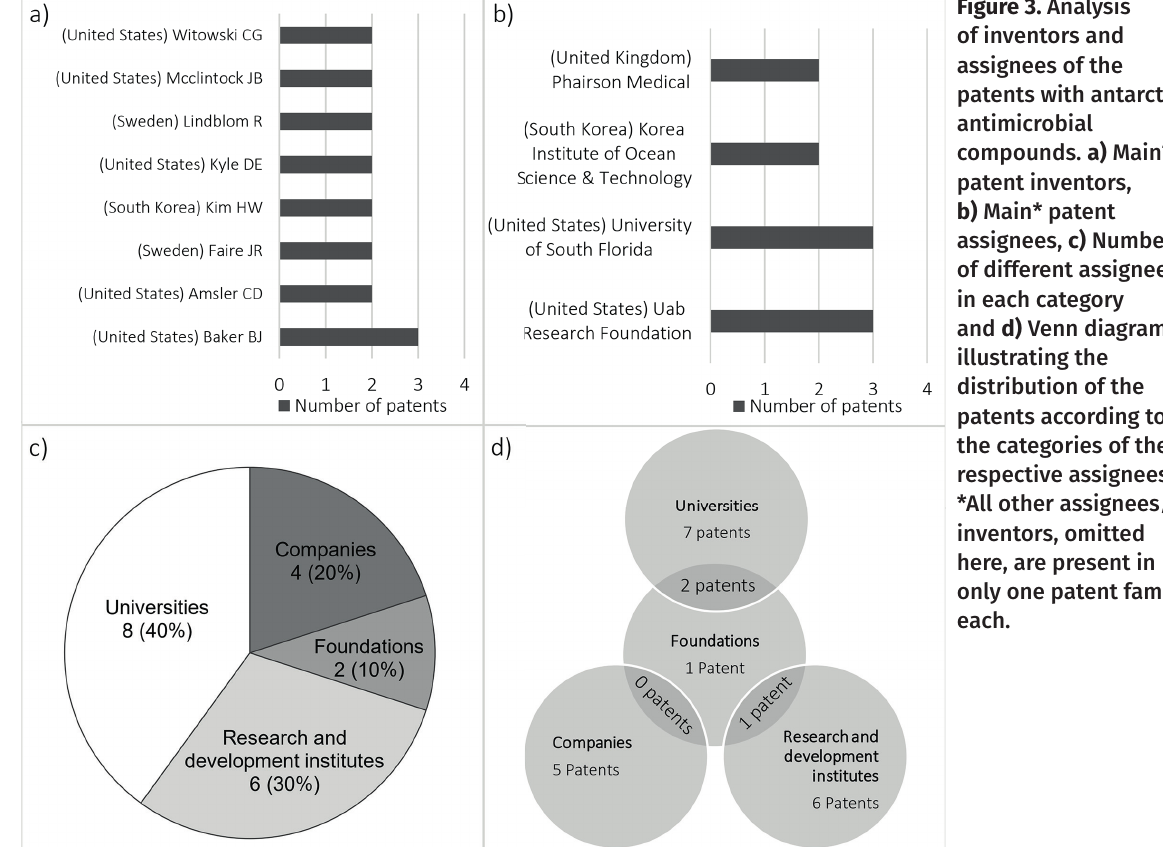
Figure 3. Analysis of inventors and assignees of the patents with